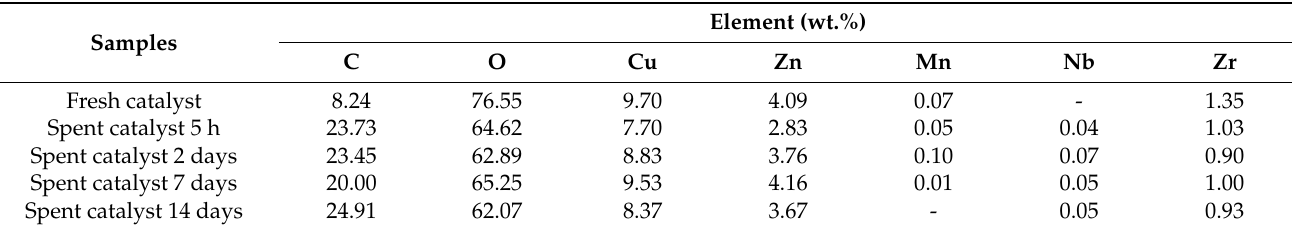
Table 3. Elemental compositions of samples using EDX analyses on carbon tape.